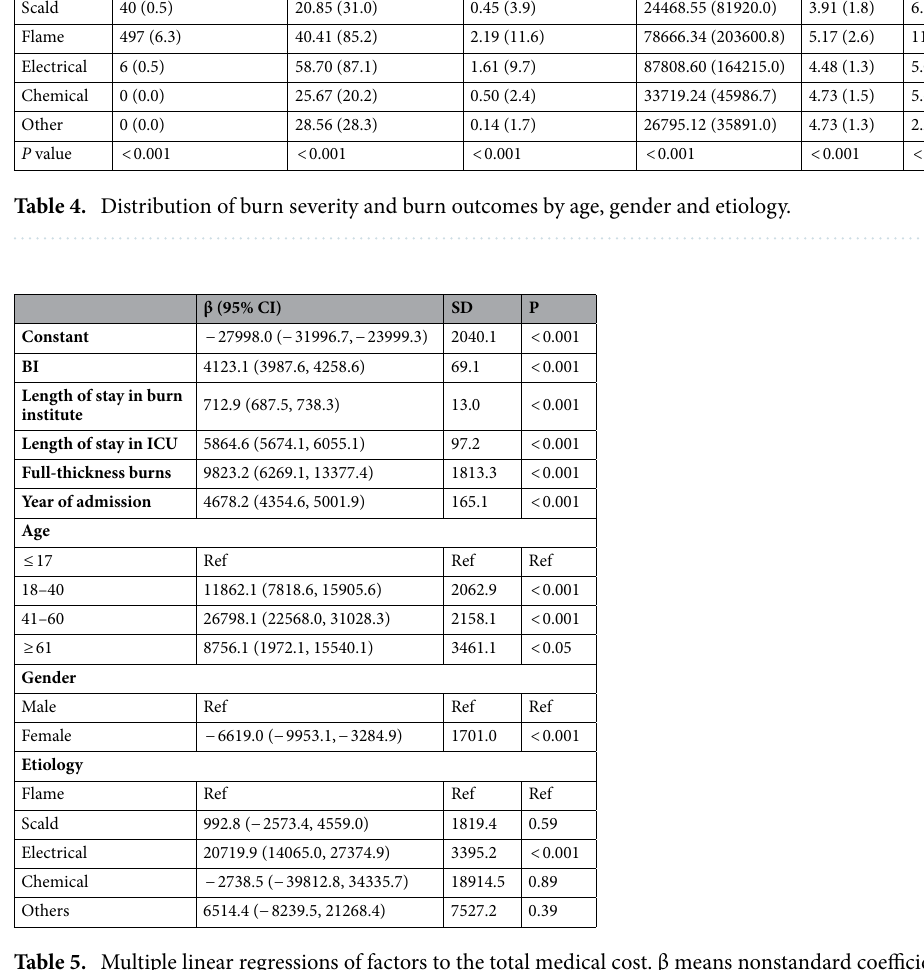
Table 5. Multiple linear regressions of factors to the total medical cost. β means nonstandard coefficients. Ref means reference item, all other items showed the relative difference value compared to the reference item. The higher of the absolute value of the β score, the higher of the contribution to the medical cost